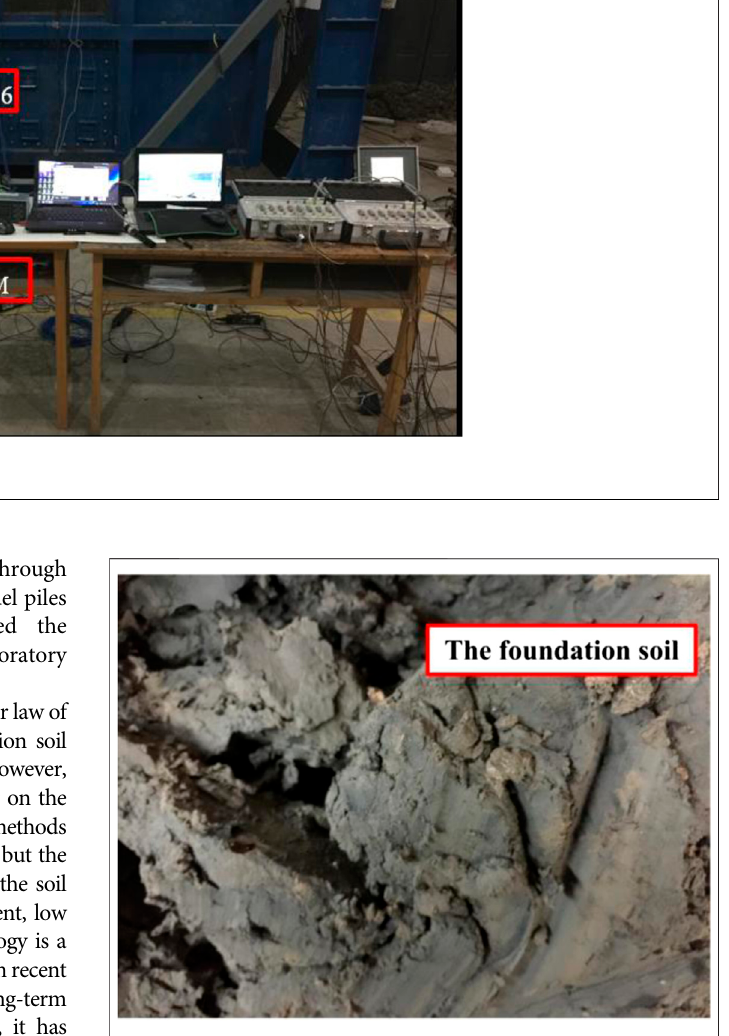
FIGURE 2 | Close-up view of the ground foundation